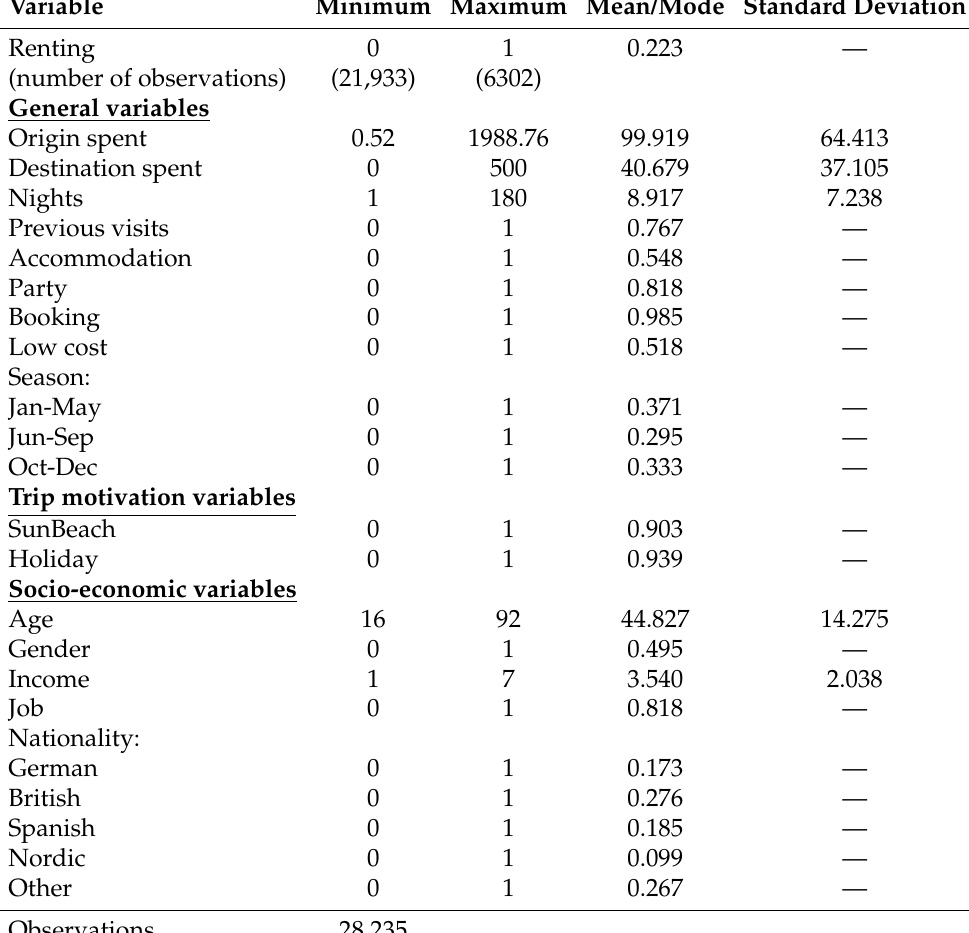
Table 1. Descriptive statistics of variables.